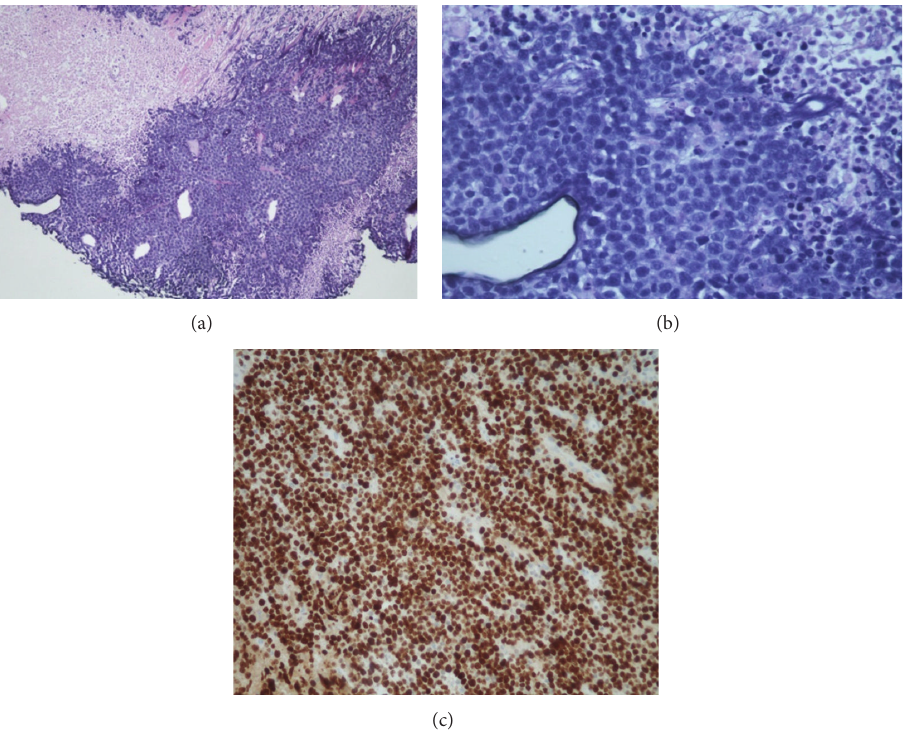
Figure 2: (a) 100x H&E image shows a monomorphic infiltrate of small round blue cells with adjacent necrosis, (b) 400x H&E high power demonstrates medium sized cells with admixed apoptotic bodies and mitotic figures reminiscent of Burkitt or a Burkitt-like lymphoma, and (c) Ki-67: high proliferation rate over 90% supports the morphologic impression and is indicative of an aggressive